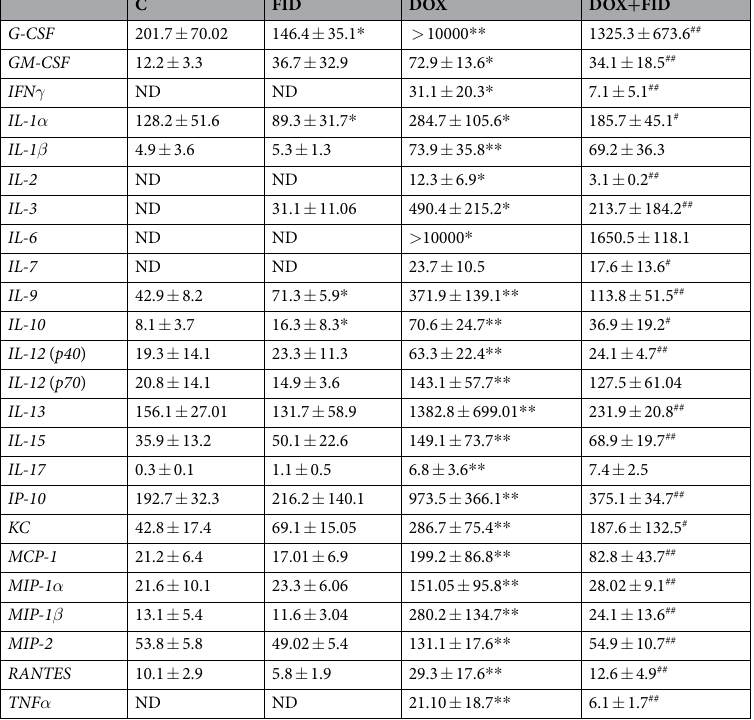
Table 2. Inflammatory cytokines in serum of C57BL/6J mice treated alone or in combination with fidarestat. Serum cytokines measured in normal mice after 10days of treatment with DOX (10 mg kg − 1 wk − 1 i.p) alone or with fidarestat in drinking water (25 mg kg − 1 ). Blood was collected from individual mouse and serum samples were analyzed by using a mouse inflammatory cytokine/chemokine magnetic bead panel (Milliplex MAP Kit) using a Millipore Milliplex analyzer system. Samples were analyzed in triplicates. Values are Mean ± SD (n = 6 in each group). * p < 0.01 vs Control; ** p < 0.001 vs Control; # p < 0.01 vs DOX; ## p < 0.001 vs DOX; ND = not